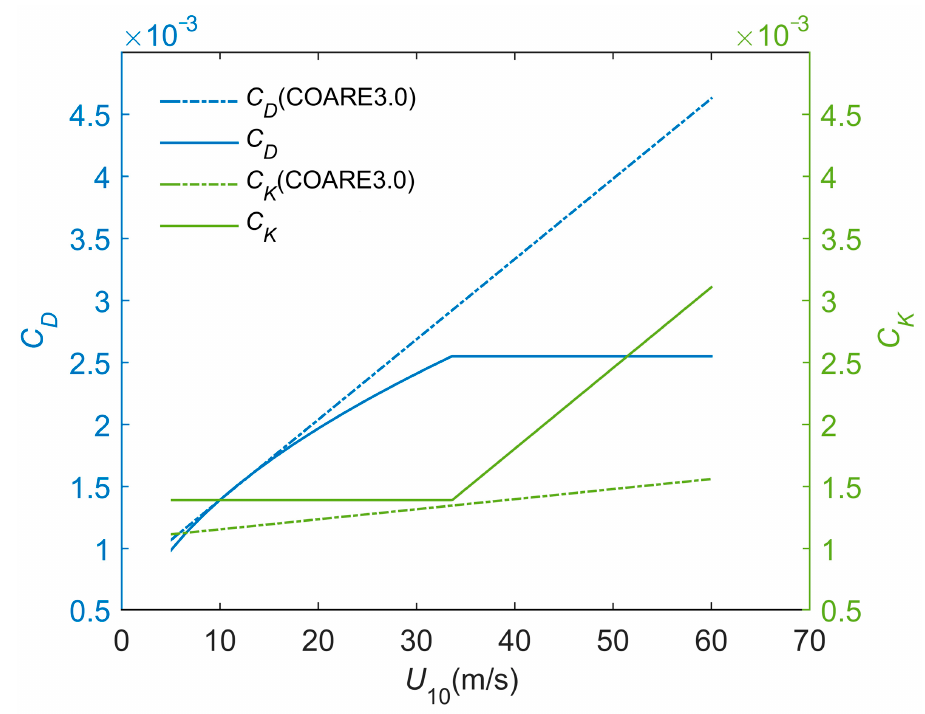
Figure 1. Variations of drag coefficient ( 𝐶 (cid:3005) ) and enthalpy exchange coefficient ( 𝐶 (cid:3012) ) with 𝑈 (cid:2869)(cid:2868)